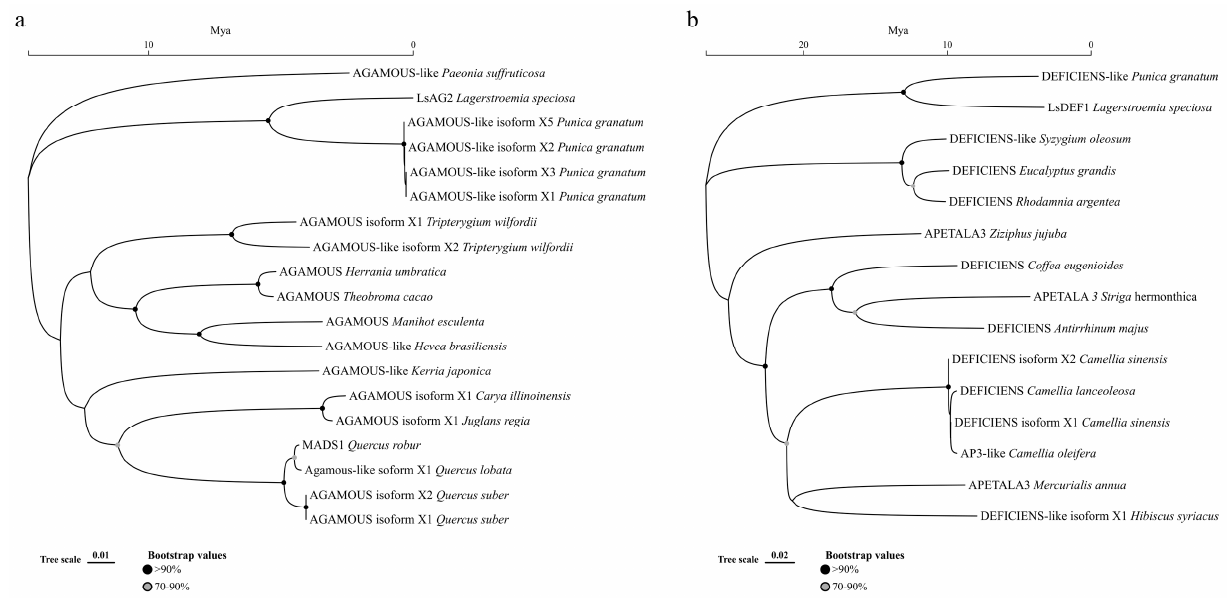
Figure 1. Phylogenetic analysis of LsAG2, LsDEF1, and other MADS-box proteins from different species. ( a ) Phylogenetic analysis of LsAG2 and MADS-box proteins of Paeonia suffruticosa , Punica ( b ) Phylogenetic analysis of LsDEF1 and MADS-box proteins of Punica granatum , Syzygium oleo- sum , Eucalyptus grandis , Rhodamnia argentea , Ziziphus jujuba , Coffea eugenioides , Striga hermonthica , Antirrhinum majus , Camellia lanceoleosa , Camellia sinensis , Camellia oleifera , Mercurialis annua , and Hi- biscus syriacus .